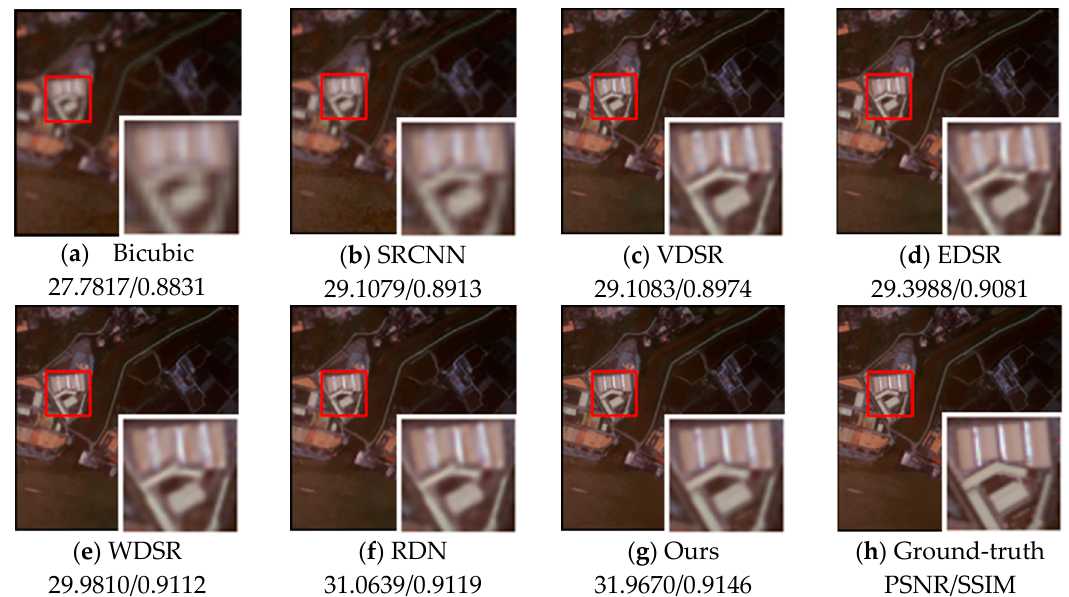
Figure 7. Qualitative comparisons of our model with other methods at the scale of ×3 on the COWC test sets.